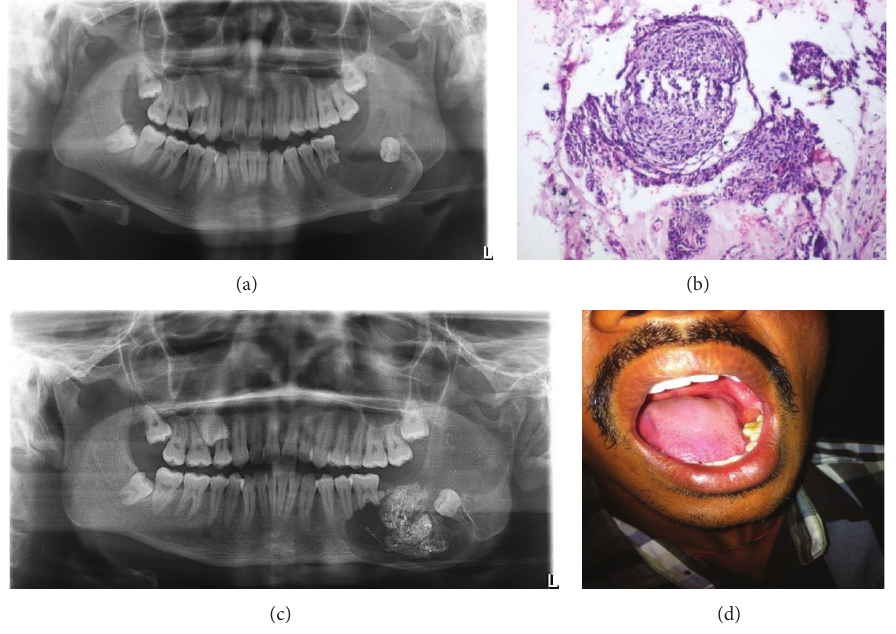
Figure 1: (a) Preoperative. (b) Histopathological slide. (c) Intraoperative. (d)